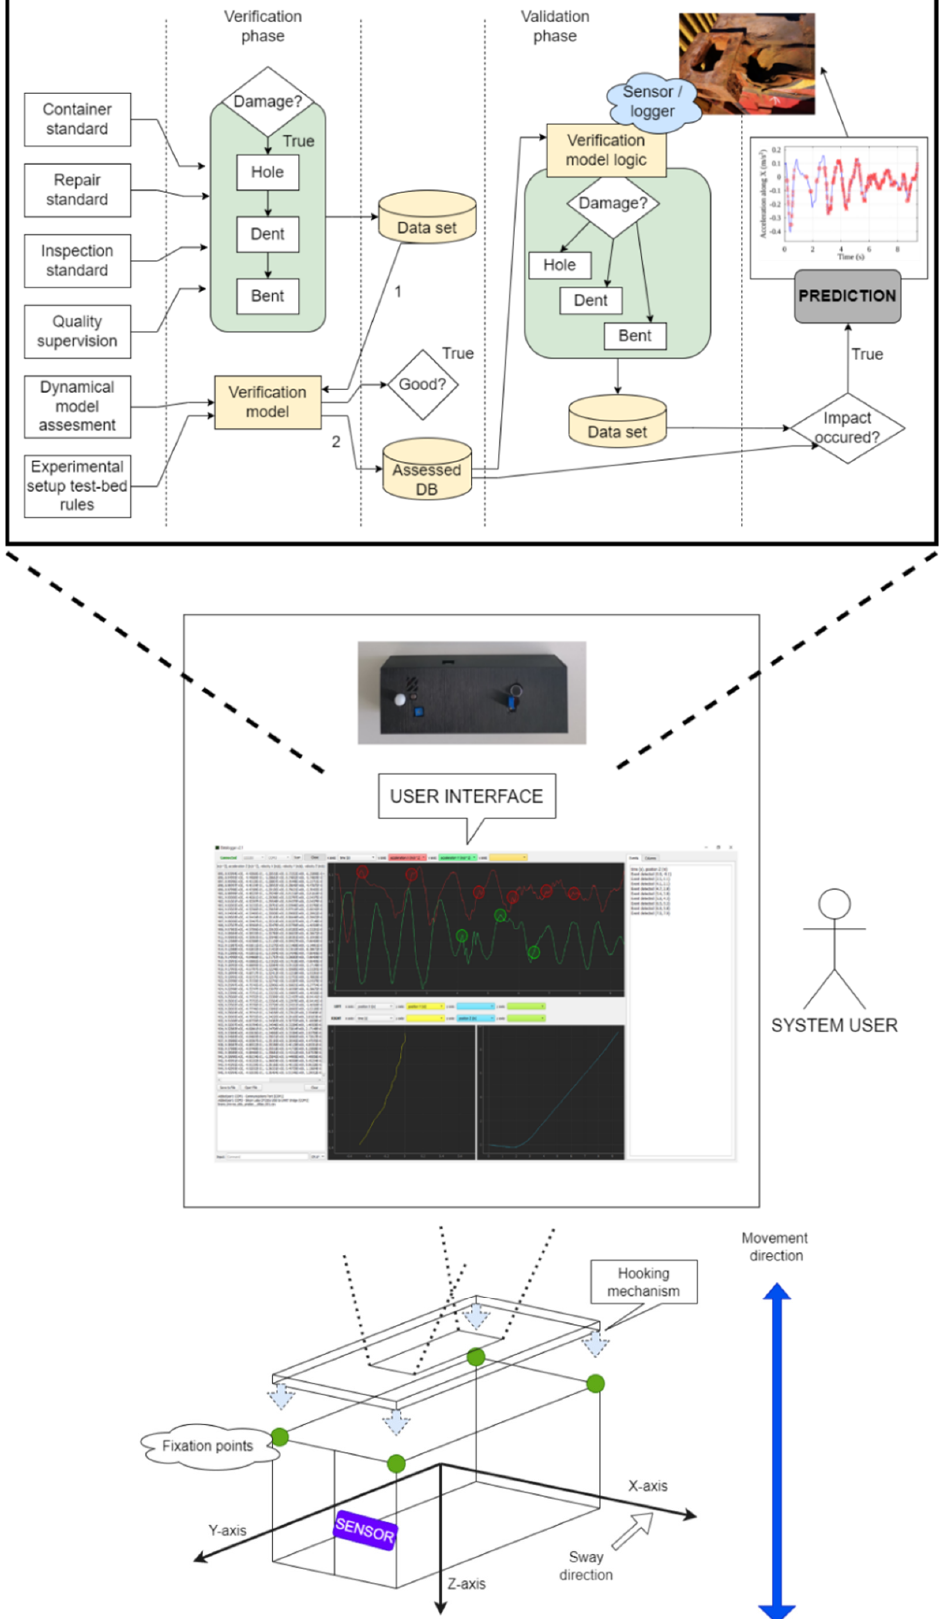
Figure 4. The research